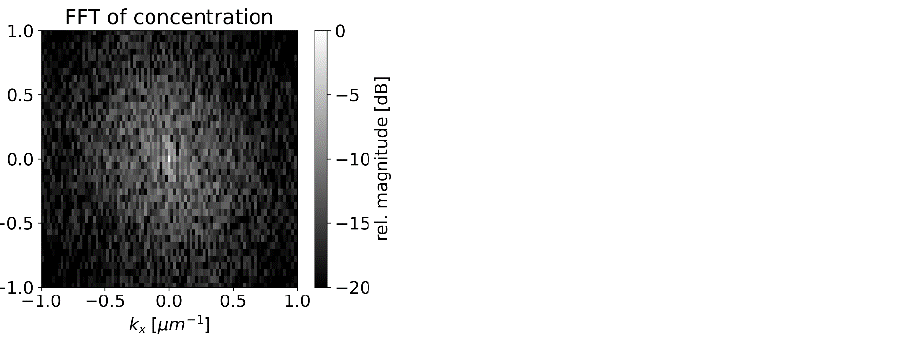
Figure 13. Small section of the discrete Fourier transformation of Carbon data (Figure 6) with the dominant frequencies.